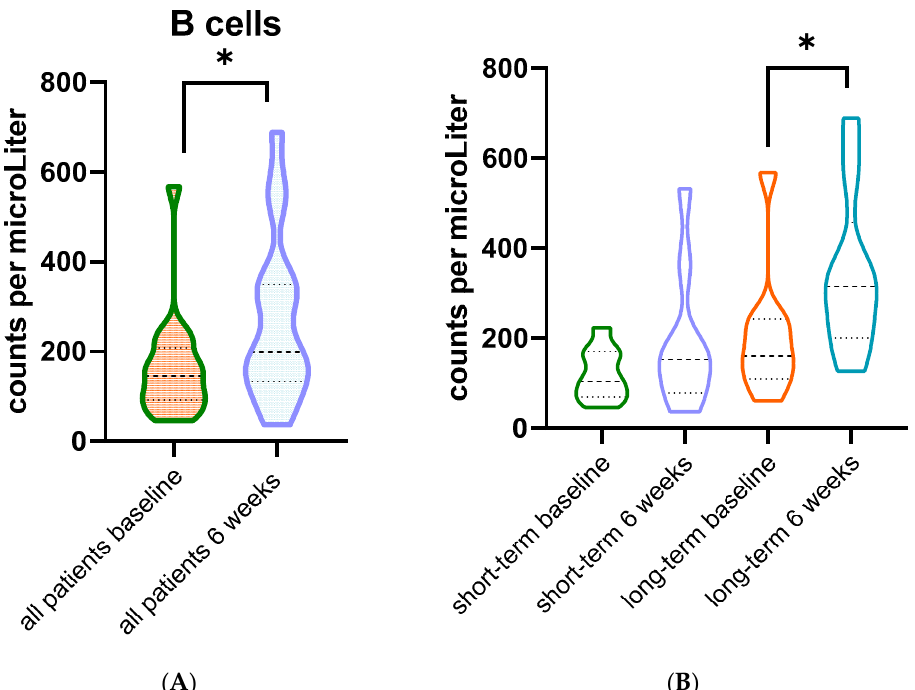
Figure 4. ( A ) B cells in circulating blood of all patients treated with rintatolimod ( n = 18, *: p = 0.001 from paired sample t -test). ( B ) B cells in circulating blood of short-term survivors ( n = 9) and long-term survivors ( n = 9 *: p = 0.002 from paired sample t -test).